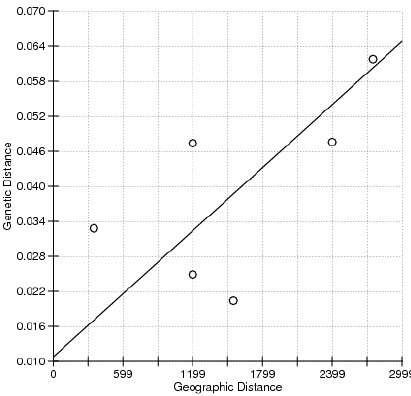
Figure 1. Plot of pairwise estimates of F st /(1 − F st ) and geographic distance. The reduced major axis (RMA) regression line overlays the scatter plots.